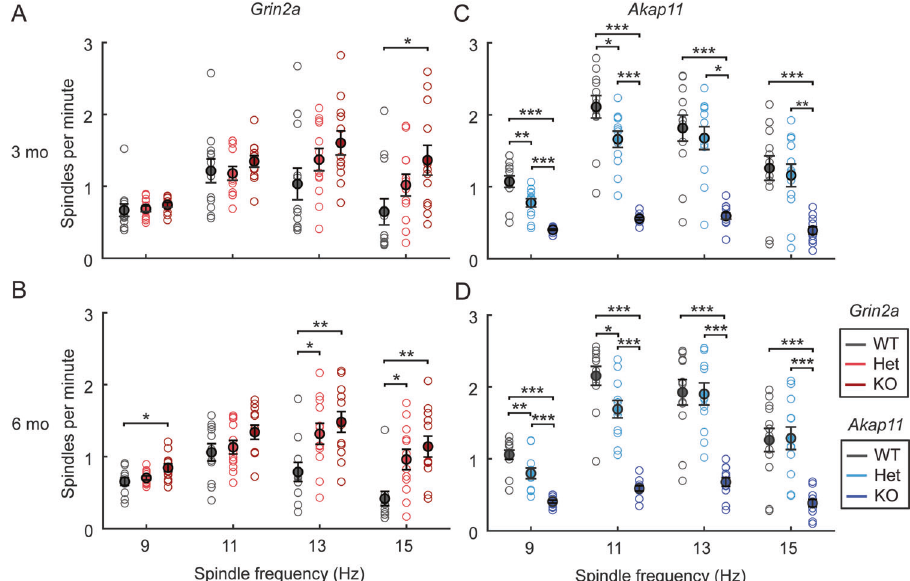
Fig. 4 Sleep spindle density in Grin2a and Akap11 mutants. A – D Density for 9 Hz, 11 Hz, 13 Hz, and 15 Hz spindles during NREM sleep during the light cycle. Error bars show mean ± standard error; p < 0.05, ** p < 0.01, *** p < 0.001; n = 11 – 12